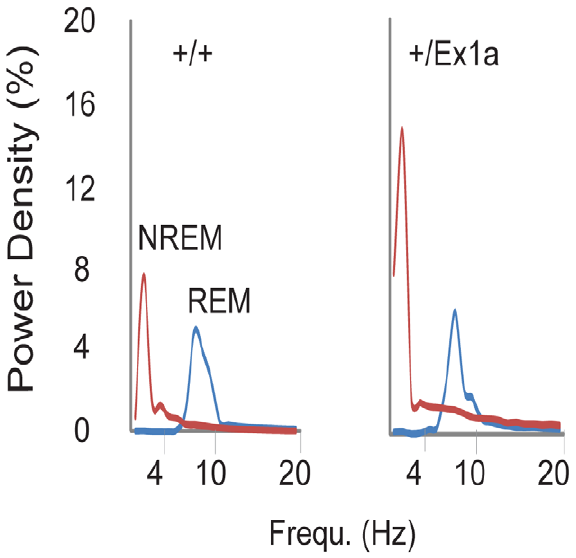
Figure 3. Representation of EEG frequencies in REM and NREM sleep. Here is represented the power density (see Methods) for all frequencies in all 4-seconds REM (blue line) and NREM (red line) sleep epochs during a 48-hour